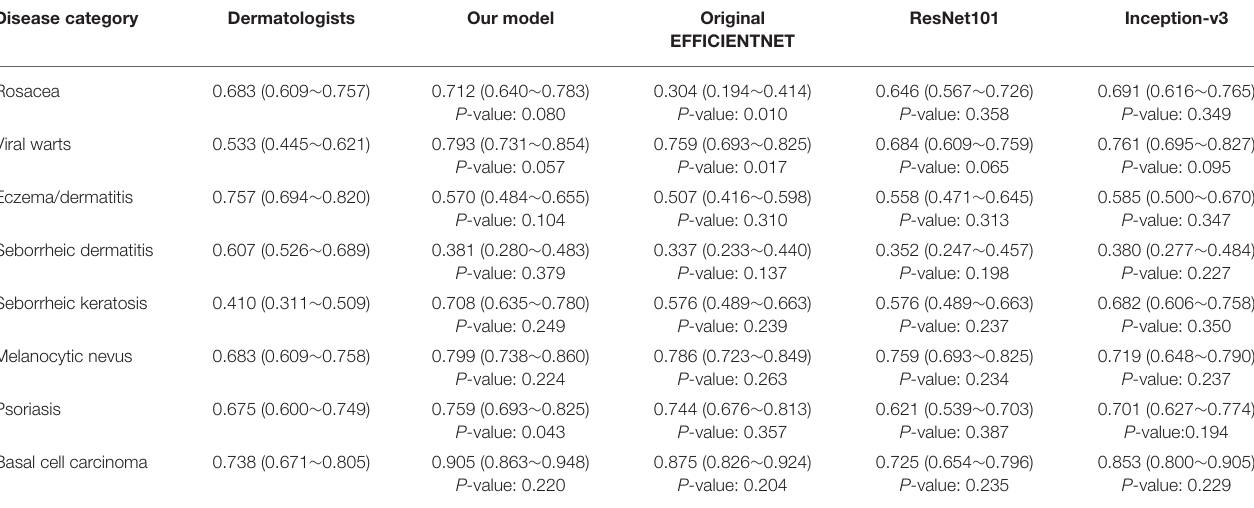
TABLE 5 | Kappa coefficients (95% confidence interval) of the included four CNN models and dermatologists (as standard) on the eight-class task. Disease